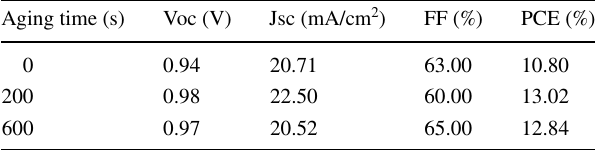
Fig. 9 J – V curves derived from different annealing temperatures Table 1 Photovoltaic properties of devices obtained from annealing temperatures of 80 °C, 85 °C, 90 °C and 95 °C, respectively